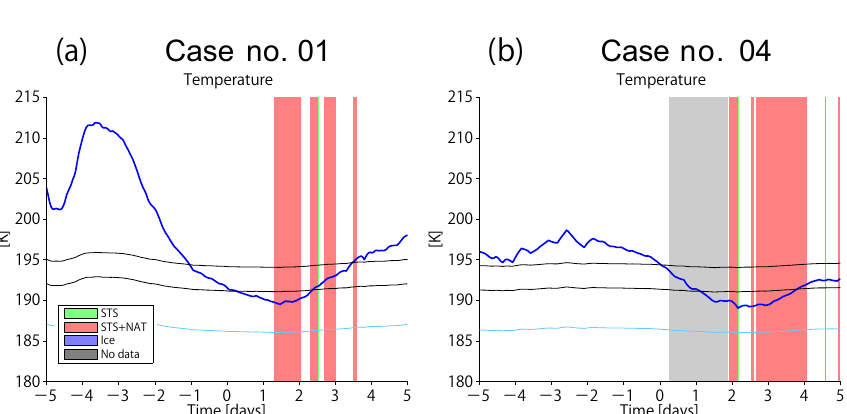
Figure 5. Temperature along the trajectories for case no. 01 (a) started at 16:37:56UT on 19 December 2009 at an altitude of 22.36km, and no. 04 (b) started at 07:58:21UT on 23 December 2009 at an altitude of 22.05km, as listed in Table 1. The color-coded areas show PSC occurrence measured by CALIOP along the trajectories, with the color code shown in lower left of panel (a) . Shaded grey area represents that PSC types were unknown due to the CALIPSO orbital limitation (>82 ◦ N). The thin black lines show the threshold temperature for NAT formation T NAT and T NAT − 3K. The thin blue line shows T ice .